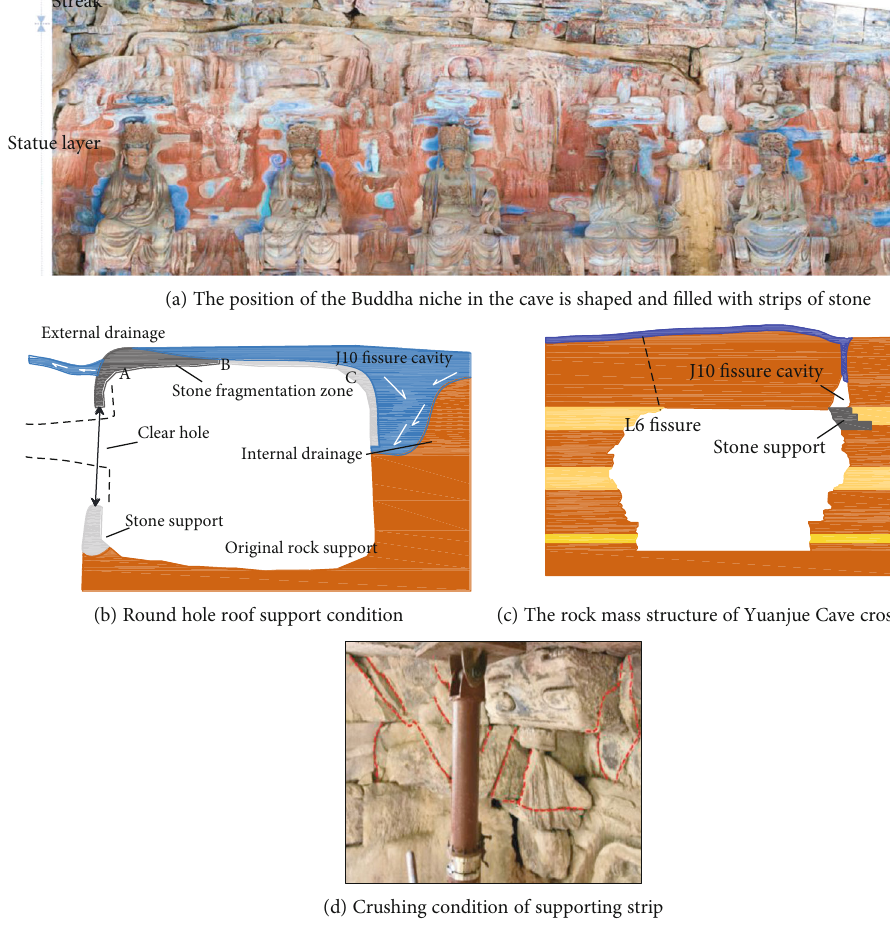
Figure 4: Preservation state of the roof support of the Yuanjue